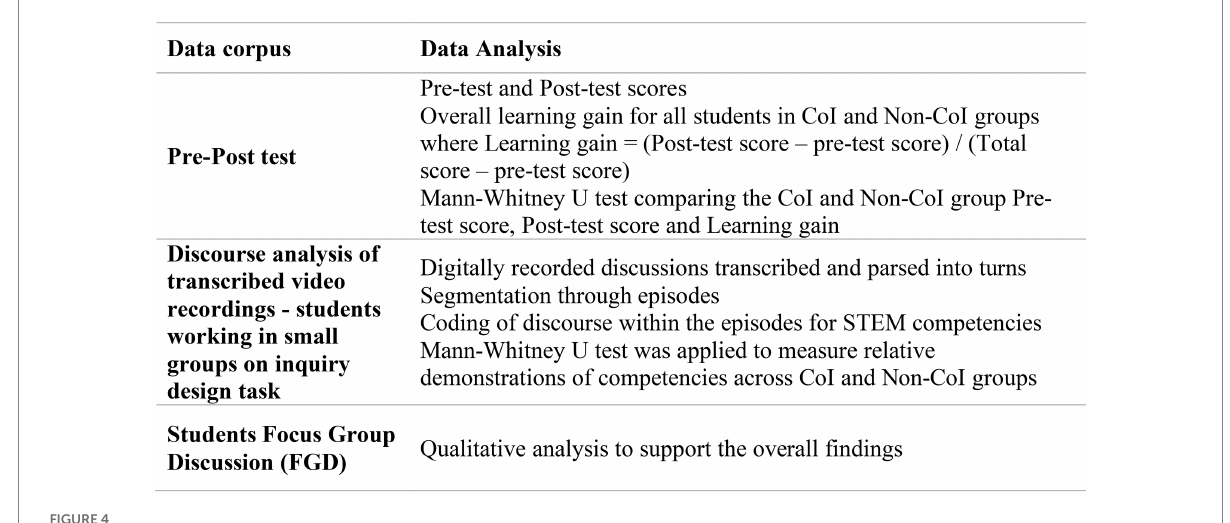
FIGURE 4 Data corpus and analyses for the